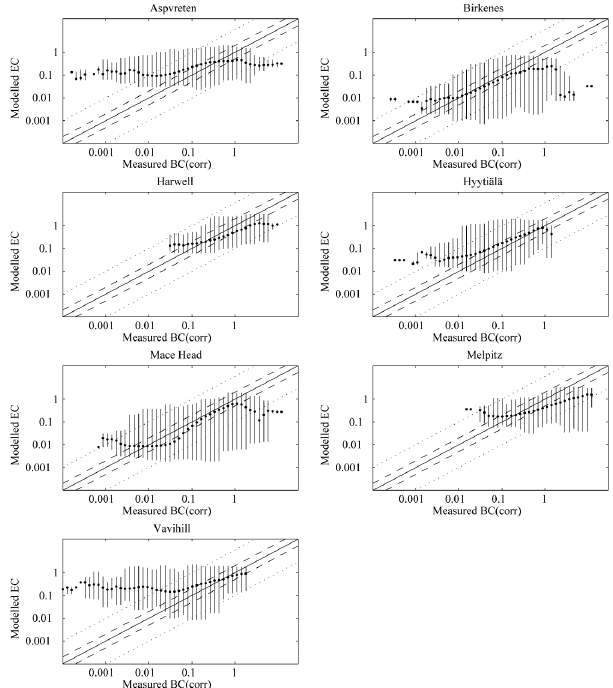
Fig. 7. Scatterplots of hourly measured BC e and modelled EC 10 (STD model version) for seven European measurement stations, (a) Aspvreten, (b) Birkenes, (c) Harwell, (d) Hyytiälä, (e) Mace Head, (f) Melpitz, (g) Vavihill. The points represent the median of model results for each concentration bin of measured BC e . Each order of magnitude is divided into 10 bins. The vertical lines represent all model results for each bin. Solid lines represent 1:1 lines. Dashed lines represent 2:1 and 1:2 lines and dotted lines represent 10:1 and 1:10 line. Unit: µg m -3 .